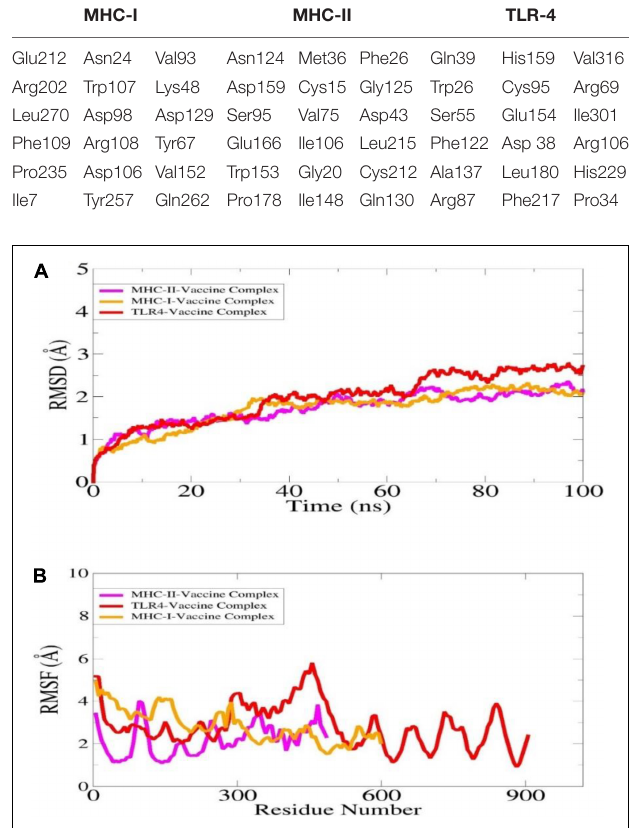
FIGURE 7 | Statistical analysis of MD simulation trajectories is illustrated here: RMSD (A) , RMSF (B)